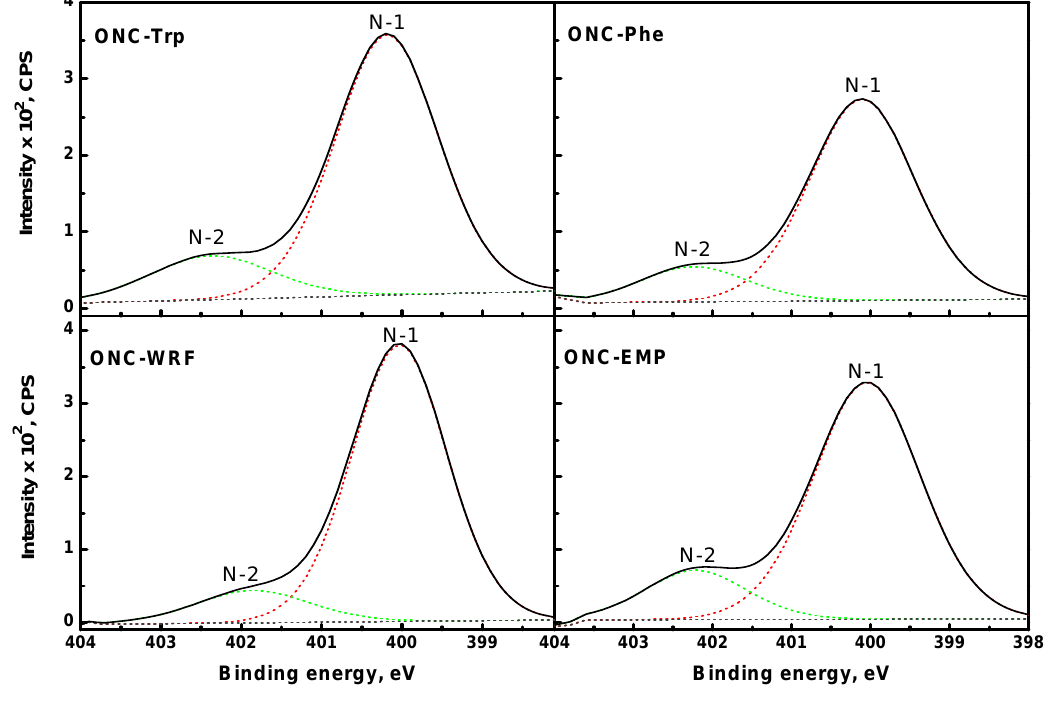
Figure 9. N 1s narrow scan XPS spectra for ONC-Phe, ONC-EMP, ONC-Trp and